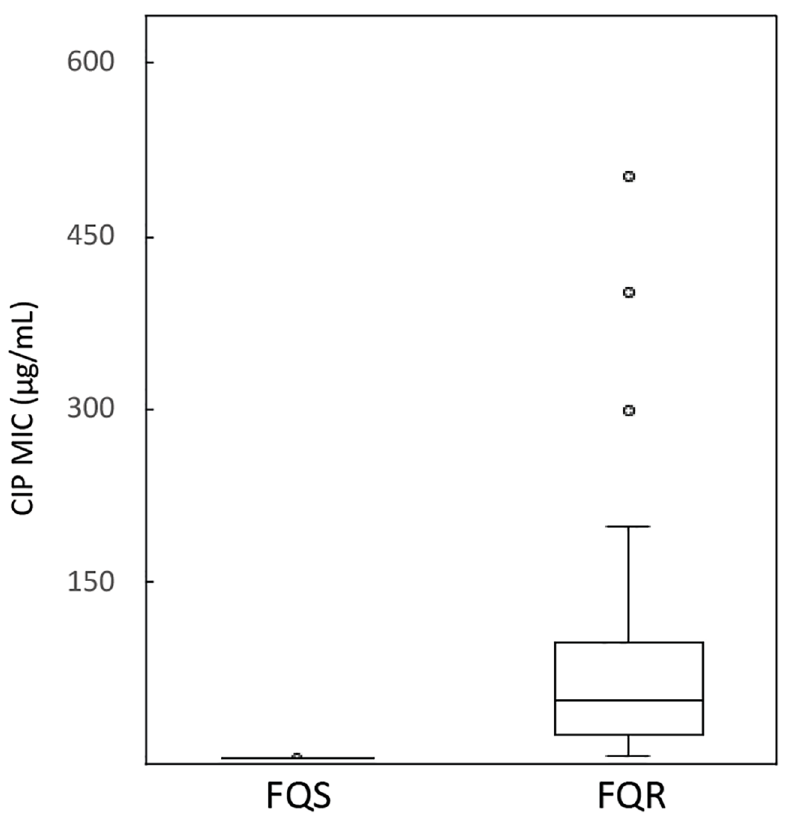
Fig 1. Ciprofloxacin MICs of E . coli clinical isolates. Box and whisker plots show the range of ciprofloxacin MICs for FQS and FQR clinical isolates. Data are from Becnel Boyd et al. 2009 [12]. Plots are divided into four quartiles, each representing 25% of the MICs (Q1: end of lower whisker to edge of box; Q2: edge of box to median line; Q3: median line to edge of box; Q4: edge of box to end of upper whisker). The length of the box is referred to as the IQR. Circles indicate outliers (here MICs higher than Q4 plus 1.5x IQR). Ciprofloxacin-susceptible isolates (MIC (cid:20) 1 μ g/ml), as determined in the microbiology laboratory of the hospital; ciprofloxacin-nonsusceptible isolates were categorized